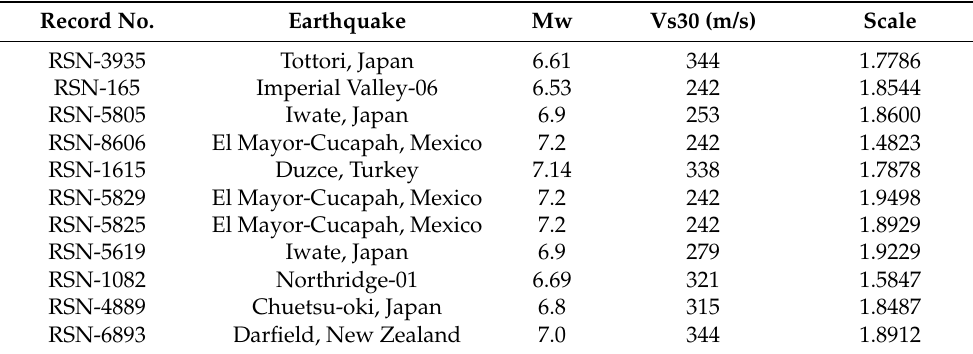
Figure 7. The spectrum of scaled acceleration records. Table 6. The properties of the selected earthquake records and scaled coefficients.